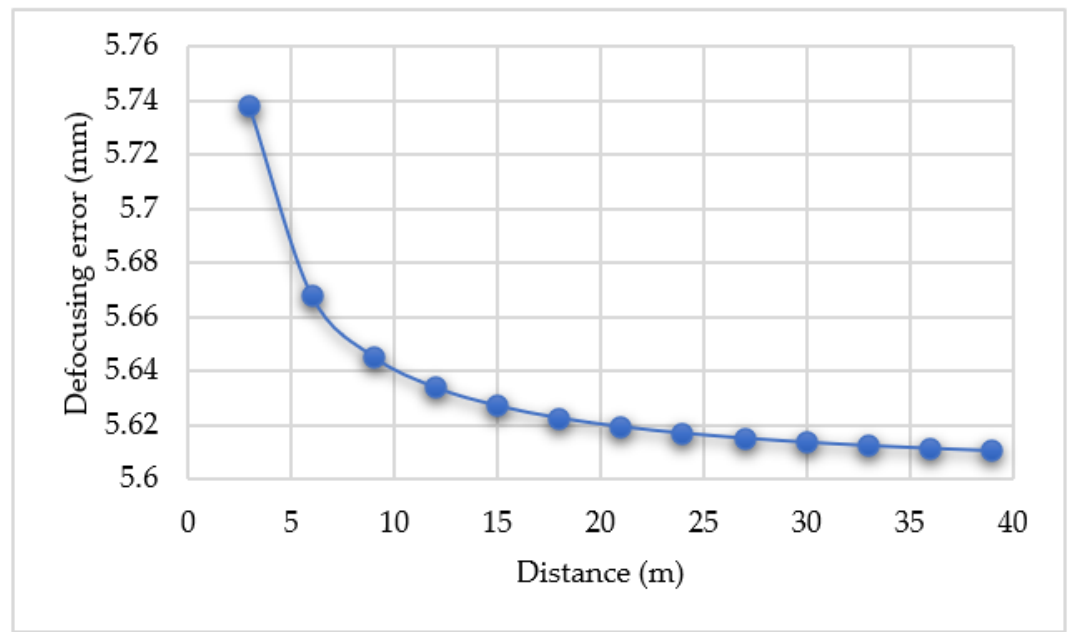
Figure 9. The graph of the defocusing error.